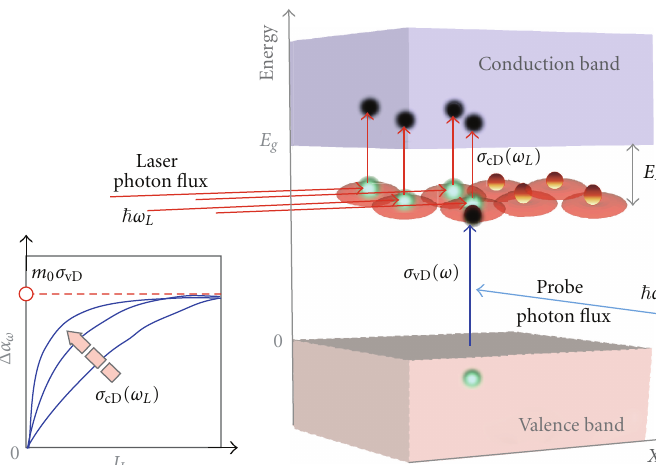
Figure 1: Illustration of the “light impact” e ff ect of the donor states depopulation by the laser pulses, completely emptying donors during the irradiation at su ffi cient density of photons. A probe beam (cid:2) ω tests the growth of induced absorption Δ α due to an emptying of the centers by laser pulses with quanta (cid:2) ω L . Intensity dependence Δ α ( I L ) is saturated with I L growth (an